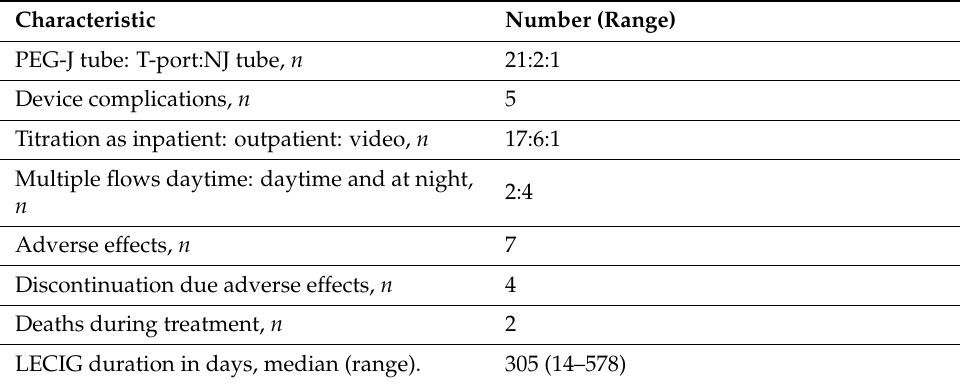
Table 2. Characteristics of LECIG infusion therapy ( n =